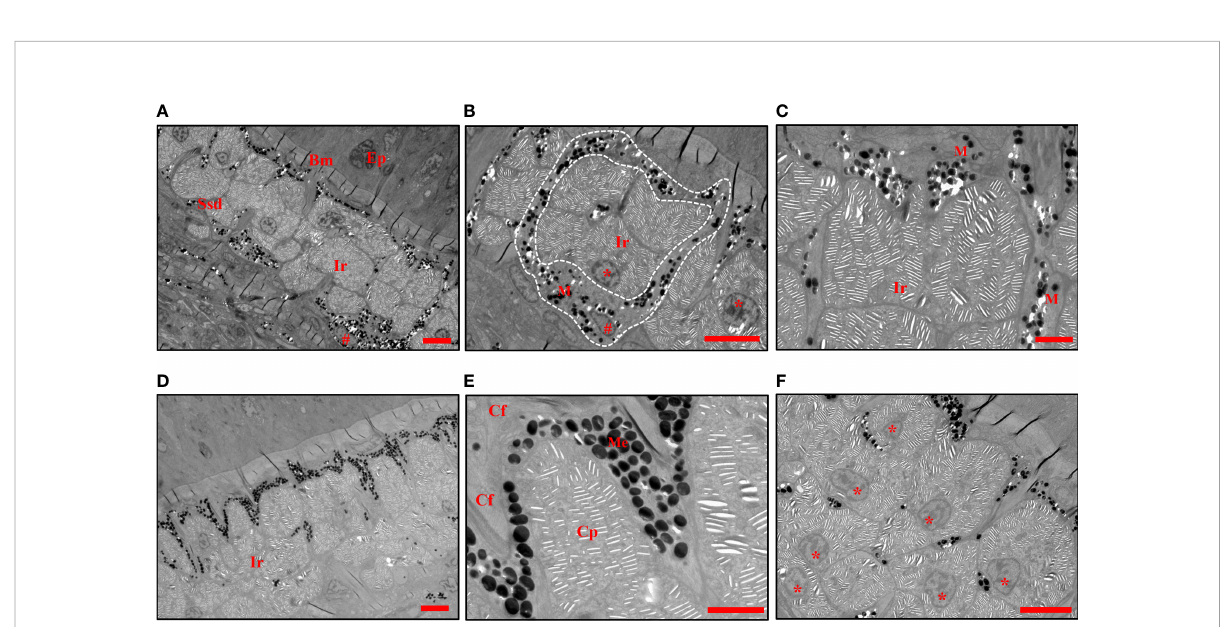
FIGURE 4 TEMs show the chromatophores in black spots. (A) The iridophores and melanophores are located in the stratum spongiosum of the dermis. (B) Melanophores containing dispersed melanosomes are seen around the iridophores (white dashed line). (C) Branches of melanophores extend their dendrites through the space between the iridophores. (D) Melanophores containing dispersed melanosomes are seen cover the iridophores. (E) The melanosomes extend up into the space between the uppermost iridophore and the subepidermal collagenous space. (F) The arrangement, shape of iridophores and their nuclei. The crystalline platelets are randomly arranged. Ep, epidermis, Ssd, stratum spongiosum of the dermis, Bm, basement membrane, Cf, collagen fi bers, M, melanophores, Me, melanosomes, Ir, iridophores, Cp, crystalline platelets. The nuclei of iridophores are indicated with an asterisk *, and those of melanophores are indicated with a pound sign #. Scale bars: 5 m m (A, B, D, F) ; 2 m m (C, E)